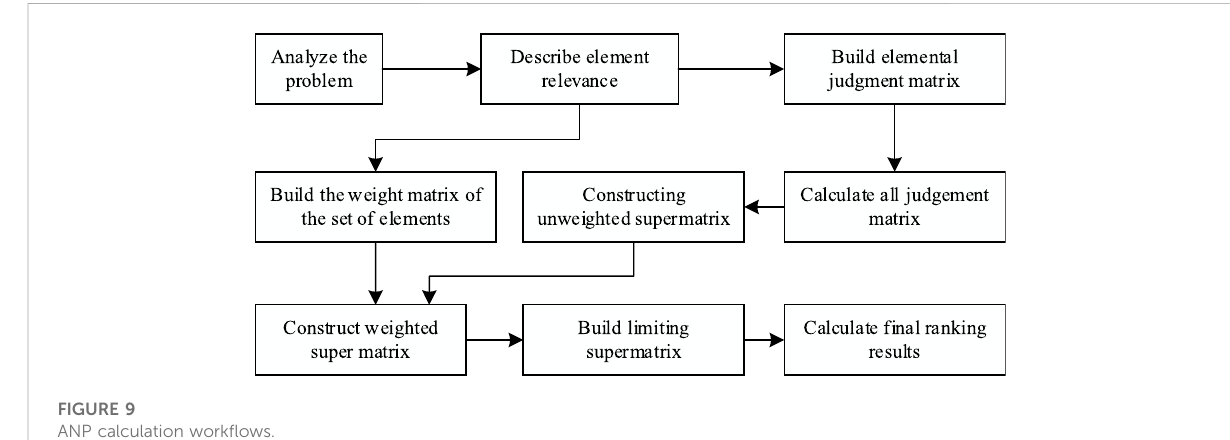
FIGURE 9 ANP calculation work fl